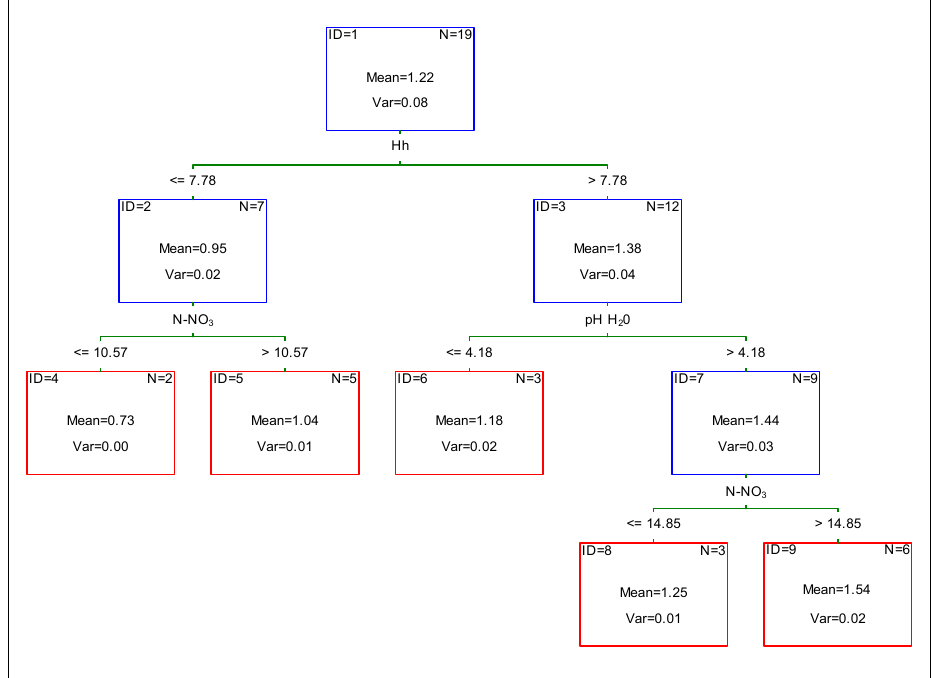
Figure 3. The regression tree (C&RT) for nitrogen content in fir needles.